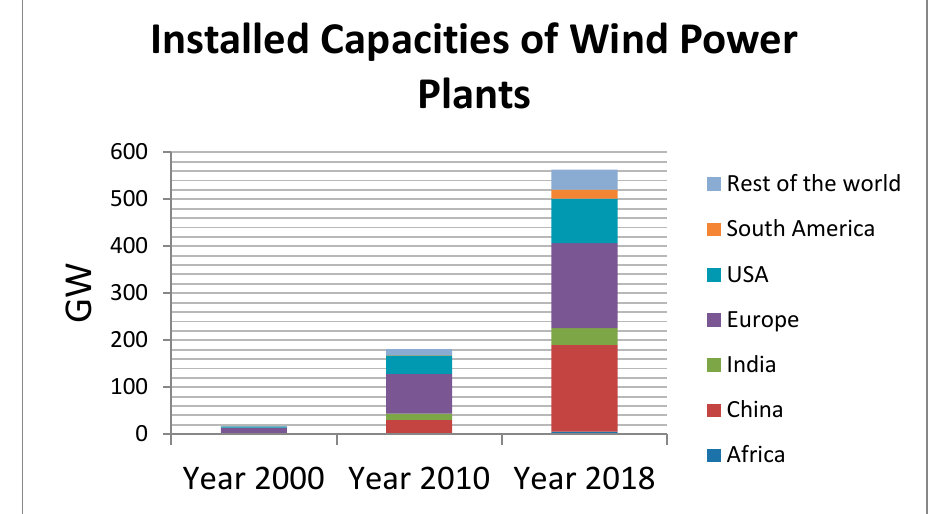
Figure 7. Installed capacities of wind power plants for selected world regions [26].